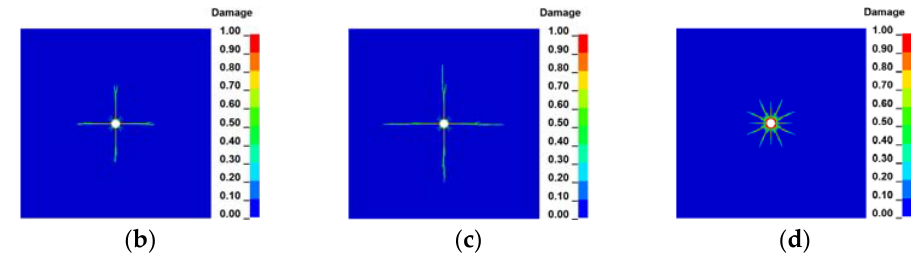
Figure 8. Crack propagation in coal under different blasting methods: ( a ) 15 μ s; ( b ) 100 μ s; ( c ) 200 μ s; ( d ) explosive blasting.